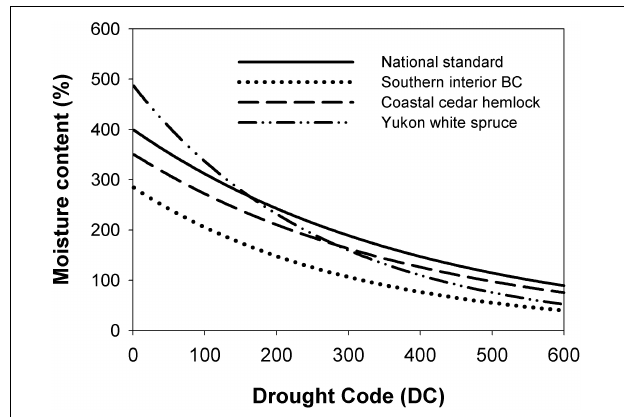
FIGURE 4 | Relationship between the Drought Code (DC) of the FWI System and the moisture content predicted in the standard function, and the moisture content of forest floor organic matter at 10 cm depth observed in 3 fuel complexes in western Canada (Lawson and Dalrymple,